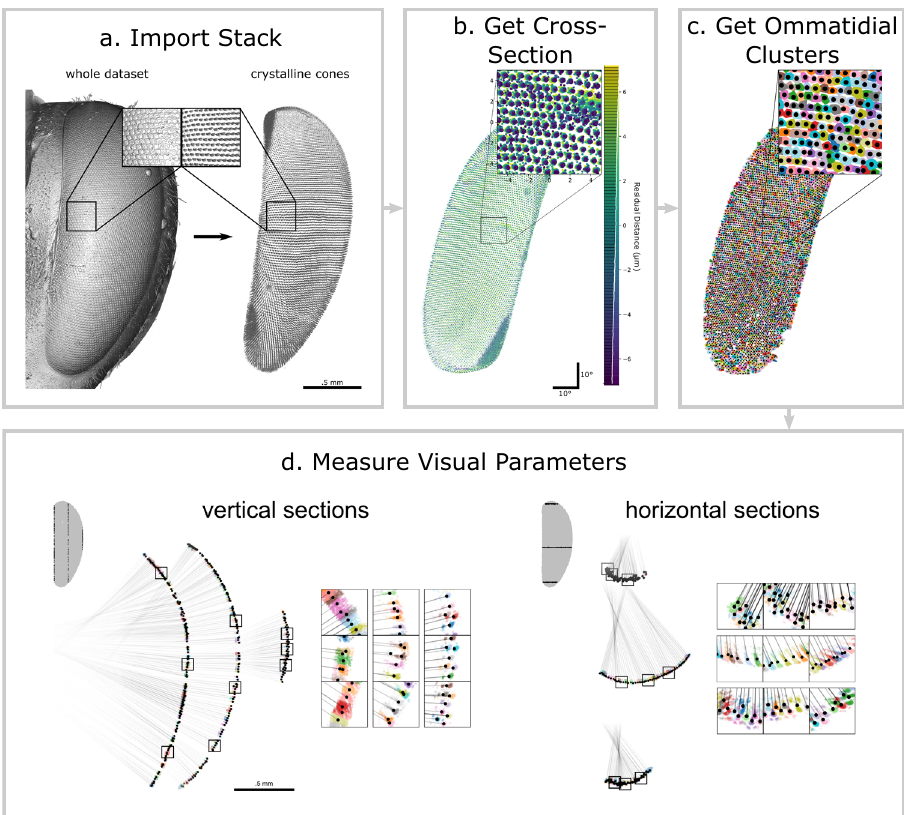
Fig. 6 Checkpoints along ODA-3D for the honeybee scan. a Import Stack : The pipeline started with an image stack that we pre- fi ltered and manually cleaned of unrelated structures. b Get Cross-Section : A surface was fi tted to the coordinates identifying a cross-section of points within 50% of the residuals. We generated a spherically projected, 2D histogram of the crystalline cone coordinates colored by their residual distance from the cross-section. c Find Ommatidial Clusters : We apply the ODA to label individual crystalline cones. The ODA locates the cluster centers, allowing us to partition the coordinates based on their distance to those centers (boundaries indicated by color- fi lled polygons). Then we cluster points based on their nearest center and apply our custom clustering algorithm to improve segmentation of more skewed ommatidia. d Measure Visual Parameters : Ommatidial diameter corresponds to the average distance between clusters and their adjacent neighbors. Ommatidial count corresponds to the number of clusters. For non- spherical eyes, we can partition the 3D coordinates into vertical ( left ) and horizontal ( right ) cross-sections in order to calculate independent vertical and horizontal anatomical IO angle components accounting for skewness in the ommatidial axes. The insets zoom into regions around the 25th, 50th, and 75th percentile ommatidia along the y-axis ( left ) and x-axis ( right ). Note: in c and d the different colors signify different crystalline cone clusters. In d , the black lines follow the ommatidial axes and the black dots indicate the cluster centroids. Also in d , note how some ommatidia in the periphery (for example, horizontal insets row 2, columns 2 and 3) were erroneously segmented and thus underestimate their skewness and IO (4) measures visual parameters of the eye (Fig. 5d). The distance between smaller segments and recentering before forming each image avoids extreme adjacent centroids approximates lens diameter. The ideal ommatidial axis is spherical warping and improves the accuracy of the algorithm. The ODA derived from planes formed by triplets of centers near the cluster, and we approximates lens centers within each segment, then recombines them into the approximate the surface normal by averaging the normal vector for each plane. original coordinate system. Finally, each point is labeled by its nearest center, Singular value decomposition fi nds the semi-axes of the ellipsoid of a cluster and effectively segmenting points into clusters corresponding to separate ommatidia our program selects the one closest to the ideal axis to estimate the anatomical (Fig. 6c). Although this works well for spherical eyes, when ommatidia are ommatidial axis. The angular difference between ideal and anatomical axes substantially skewed the overlap of projected clusters prevents the algorithm estimates anatomical skewness. from segmenting correctly, often splitting up proper clusters among their Anatomical axes of neighboring ommatidia should yield reliable IO angles, but neighbors. Optionally, our program can identify these problematic clusters and the raw axes are highly variable. While greater resolution, or using other structures attempt to correct them using a custom clustering algorithm. Problematic to extend approximations closer to the intersection, could improve accuracy, our clusters are identi fi ed as those with a large proportion ( ≥ 10%) of elements whose program reduces variability by replacing each anatomical axis with the average axis nearest neighbors were elements of a different cluster. For each problematic of a local neighborhood of clusters (akin to the rosette averaging procedure used cluster, the algorithm fi nds the immediate neighborhood of 6 clusters and in 54 ). The program allows the user to determine the radius of this neighborhood in applies a nonlinear minimization algorithm (Scipy ’ s differential evolution) to minimize both 1) the mean projected distance between each point and its cluster terms of ommatidial diameter: a radius of 1 speci fi es immediate neighbors within center and 2) the aspect ratio of the cluster ’ s longest side to its shortest in 3D. one diameter, 2 speci fi es immediate neighbors and immediate neighbors of those, Because the clusters are approximately parallel on a small scale and elongated and so on. Here we used a radius of 5. In general, this has the effect of reducing along the ommatidial axis, this process often converges on the plane orientation local variability in IO angles while maintaining global patterns. However, it also orthogonal to the clusters ’ longitudinal axes. The program only incorporates skews axes close to the boundary of the eye towards the center due to the these cluster corrections if they result in substantially less problematic elements asymmetrical participation of neighboring points, thus reducing FOV estimates. As (<5%). This dramatically improves cluster segmentation for nonspherical eyes a compromise, in addition to allowing the user to determine the neighborhood like the honeybee scan and adds a trivial amount of time to the program ’ s total radius, our program uses the neighborhood-averaged angles for IO angle duration. Optionally, our program also allows the user to manually edit cluster measurements but the raw axes for measuring the projected FOV. centers (Supplementary Fig. 1C – D) and then displays the outcome of this To calculate anatomical IO angles, our program partitions coordinates into segmentation (Supplementary Fig. 1E) evenly spaced vertical and horizontal sections (Fig. 6d), in which we projected